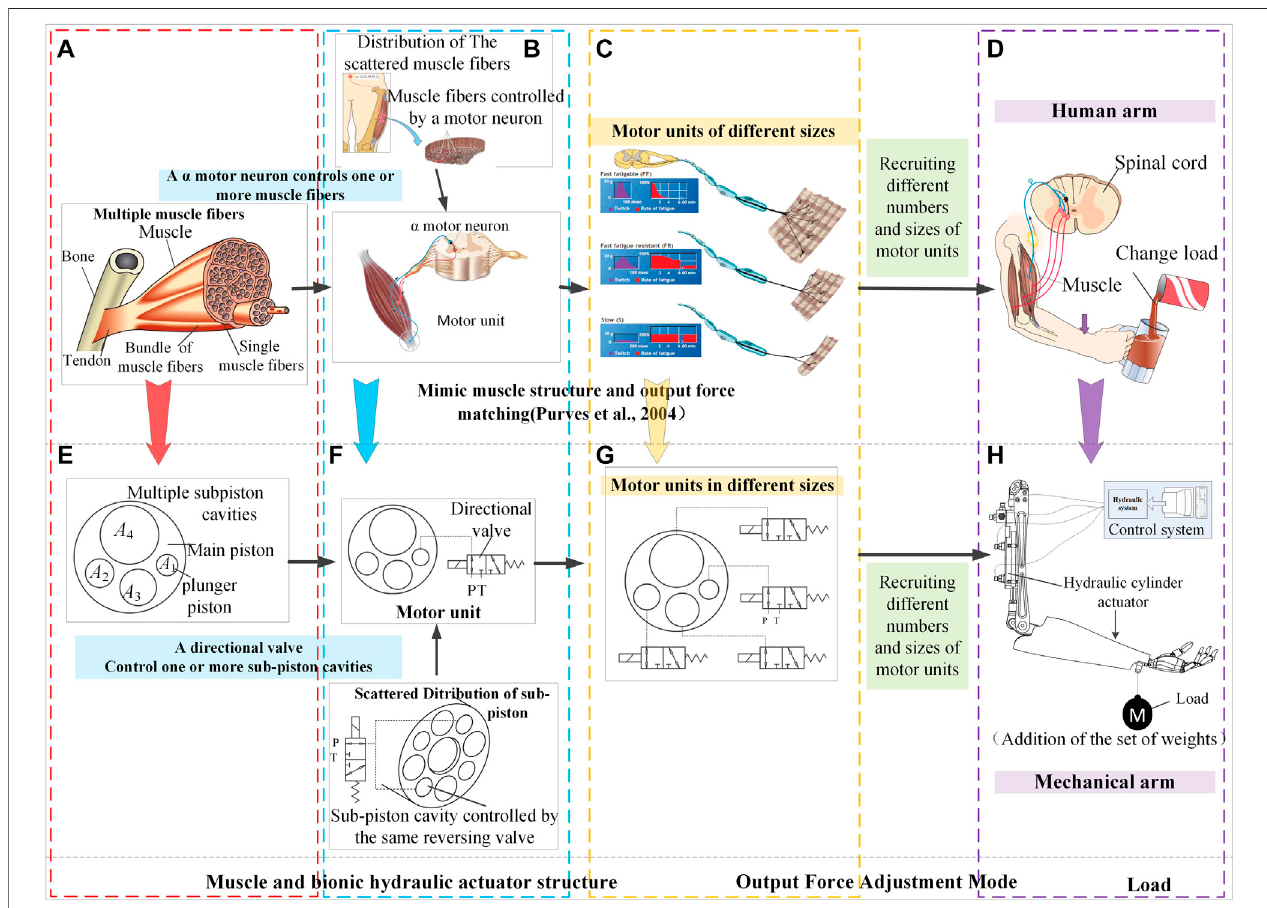
FIGURE 1 | Biomimeticdesignmechanismofanewbionichydraulicactuatorbyimitatinghumanmuscles; (A) to (E) :Mimicthestructuralcharacteristicsofhumanmuscle multi-motorunits; (B) to (F) :Mimicthecontrolofhumanmusclesanddispersionanddistributionofamusclemotorunitascloselyaspossibleonthecross-section; (C) to (G) :Mimic the scale difference of human muscle motor units and the recruitment patterns of muscle motor units; (D) to (H) . Comparison of human arm and robotic arm.